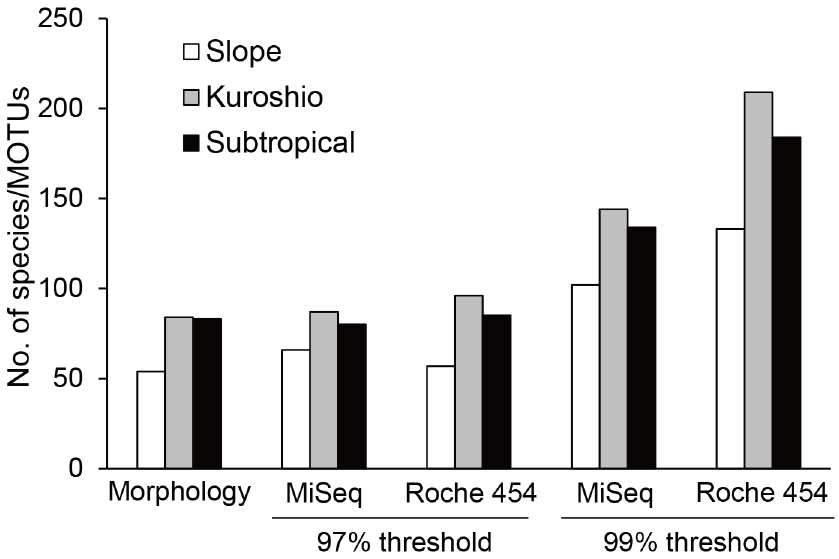
Fig 2. Total species and MOTU numbers of copepods in field-collected samples. MOTU numberswere calculatedat 97 and 99% similarity thresholdsin metagenetic analysesusing both IlluminaMiSeq and Roche 454